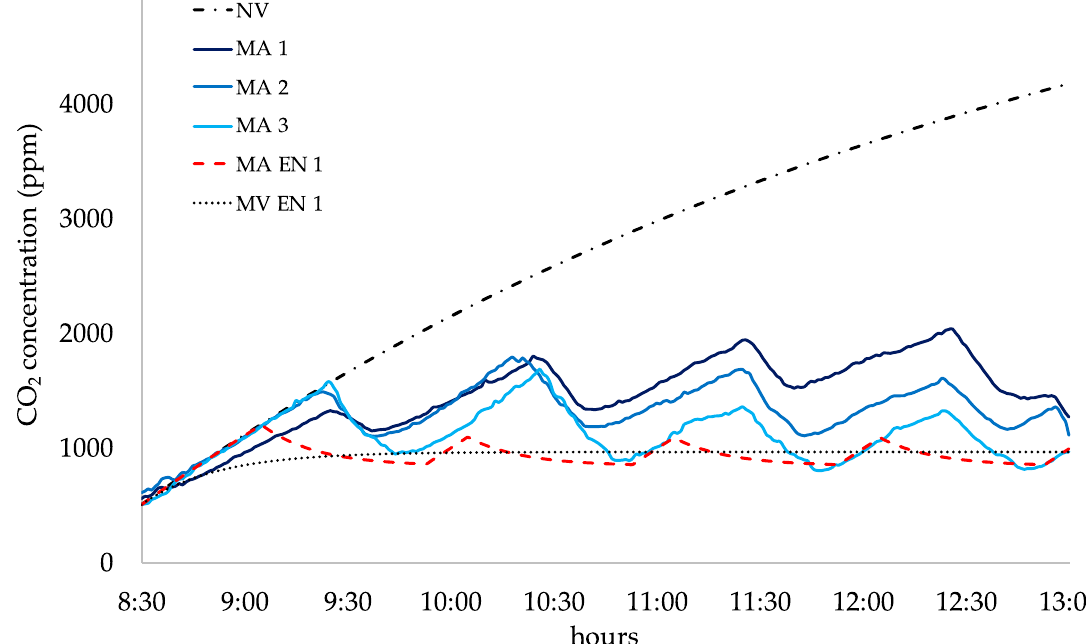
Figure 5. CO 2 trends measured during manual airing tests (MA 1, MA 2, and MA 3), estimated for natural ventilation (NV), manual airing (MA EN 1) and mechanical ventilation (MV EN 1) for the same crowding index (2.2 m 2 person − 1 ). Dashed lines represent estimated values, whereas solid lines are used for measured values.